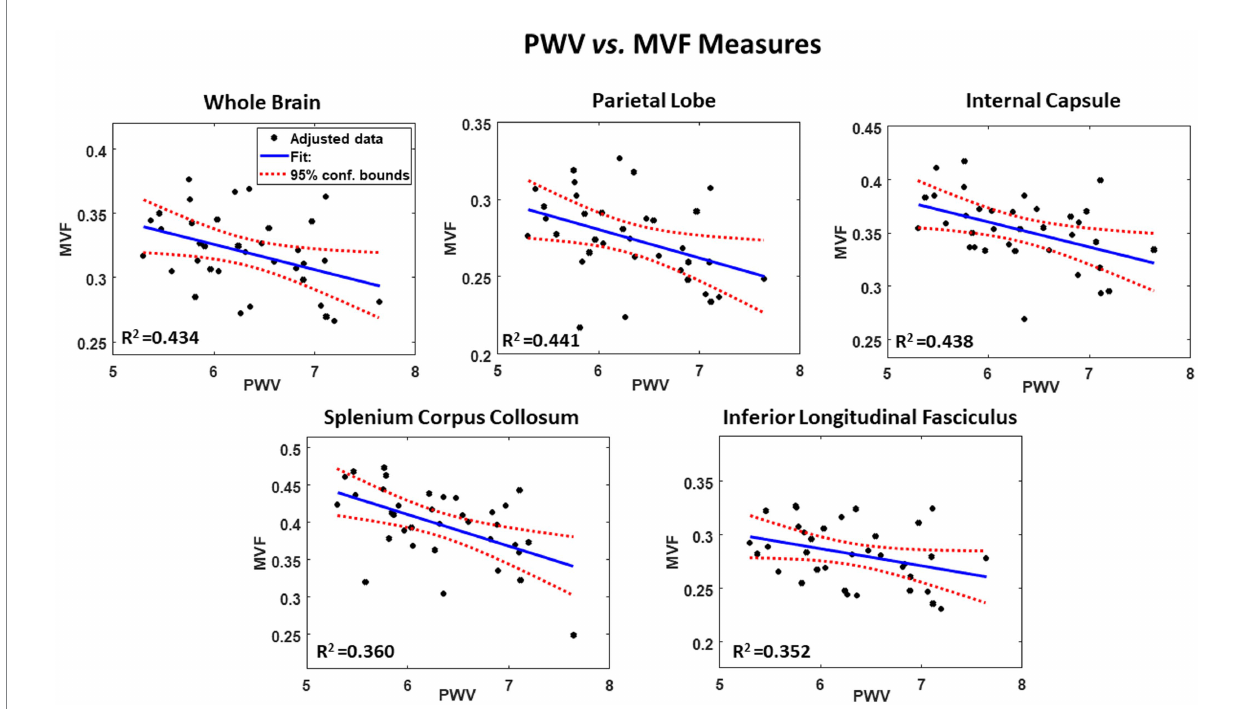
FIGURE 2 Example of regressions of MVF with carotid femoral pulse wave velocity (PWV), adjusted for age, sex, smoking, and SBP. Results are shown for 5 representative cerebral structures. For each plot, the coefficient of determination, R 2 , the line of best fit (blue solid line) and confidence intervals (red dashed lines) are